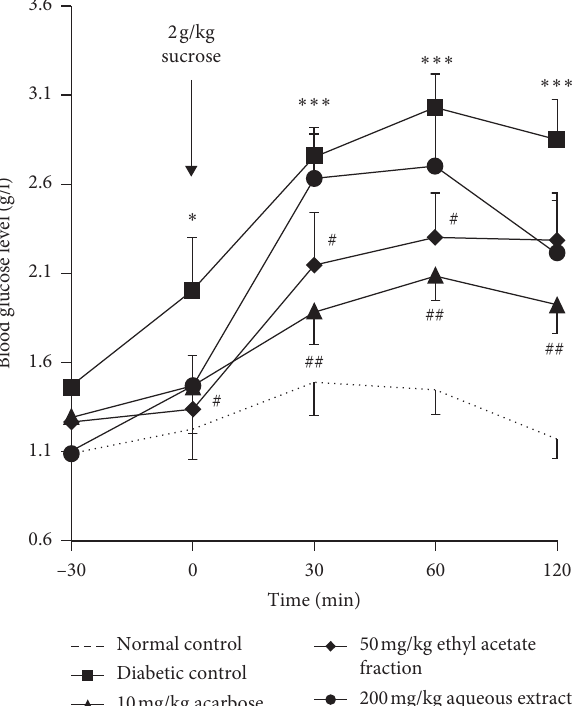
Figure 1: Effect of daily oral administration of aqueous extract (AqTh), ethyl acetate fraction (EaTh) of T. hirsute , and acarbose during 4 weeks on fasting blood glucose in STZ-diabetic rats. Rats were deprived of food for 14h, and then blood samples were collected from the tail tip under light ether anesthesia. Each value represents the means ± SEM. n � 5-6. ∗ p < 0 . 05 and ∗∗∗ p < 0 . 001 compared with the normal group at each point. # p < 0 . 05, ## p < 0 . 01, and ### p < 0 . 001 compared with the diabetic group at each